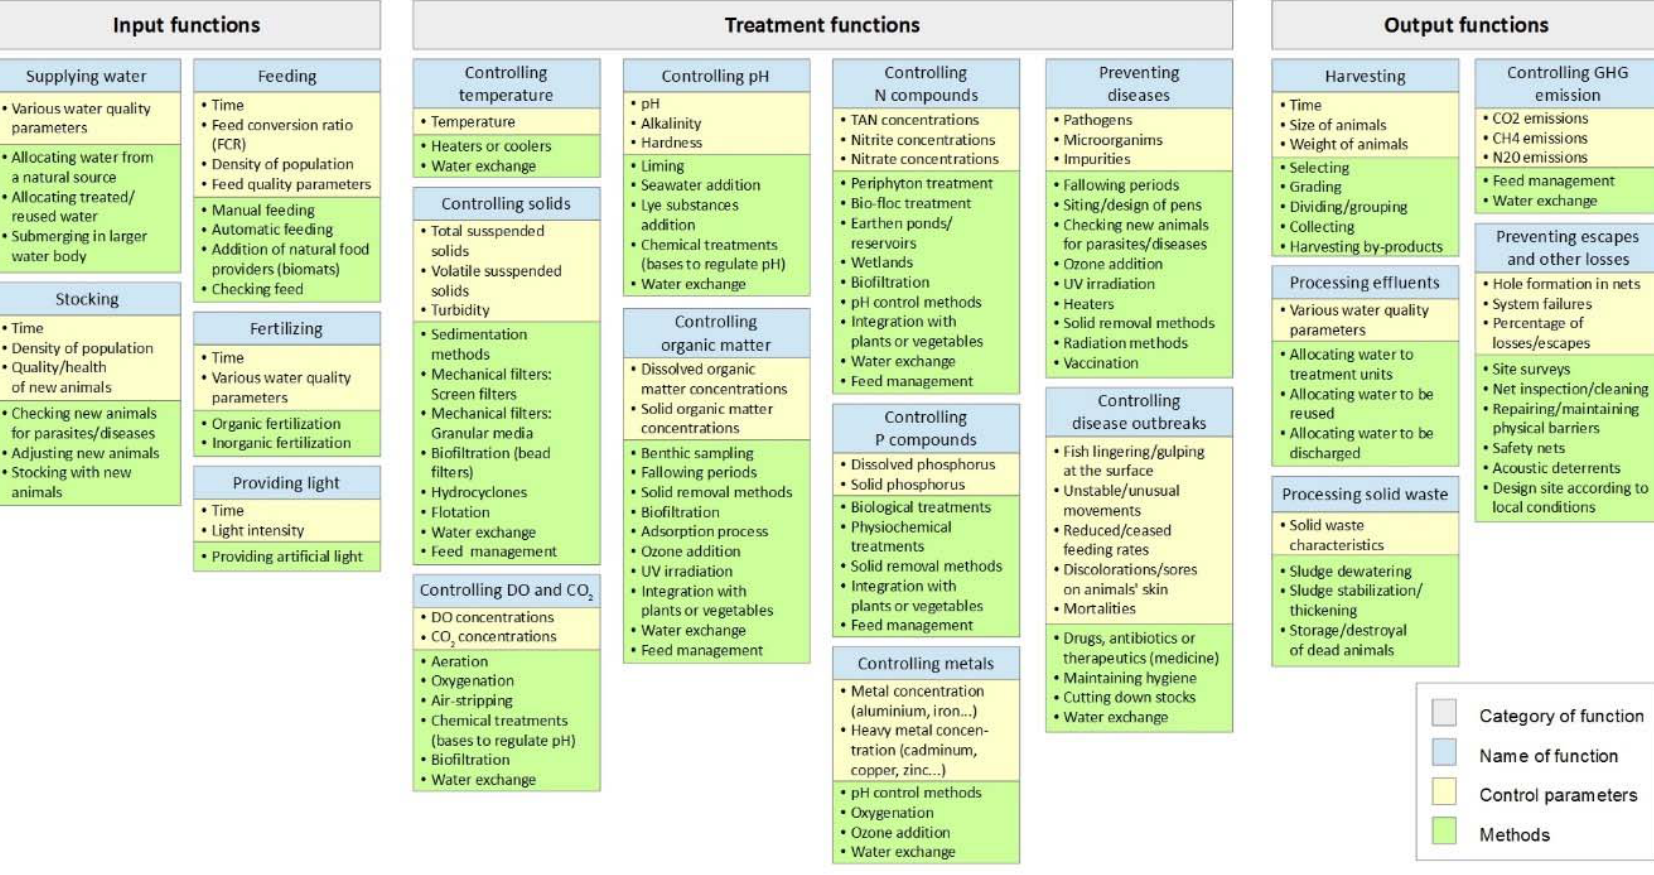
Figure 2. The map of aquaculture production systems displaying input functions, treatment functions, and output functions.